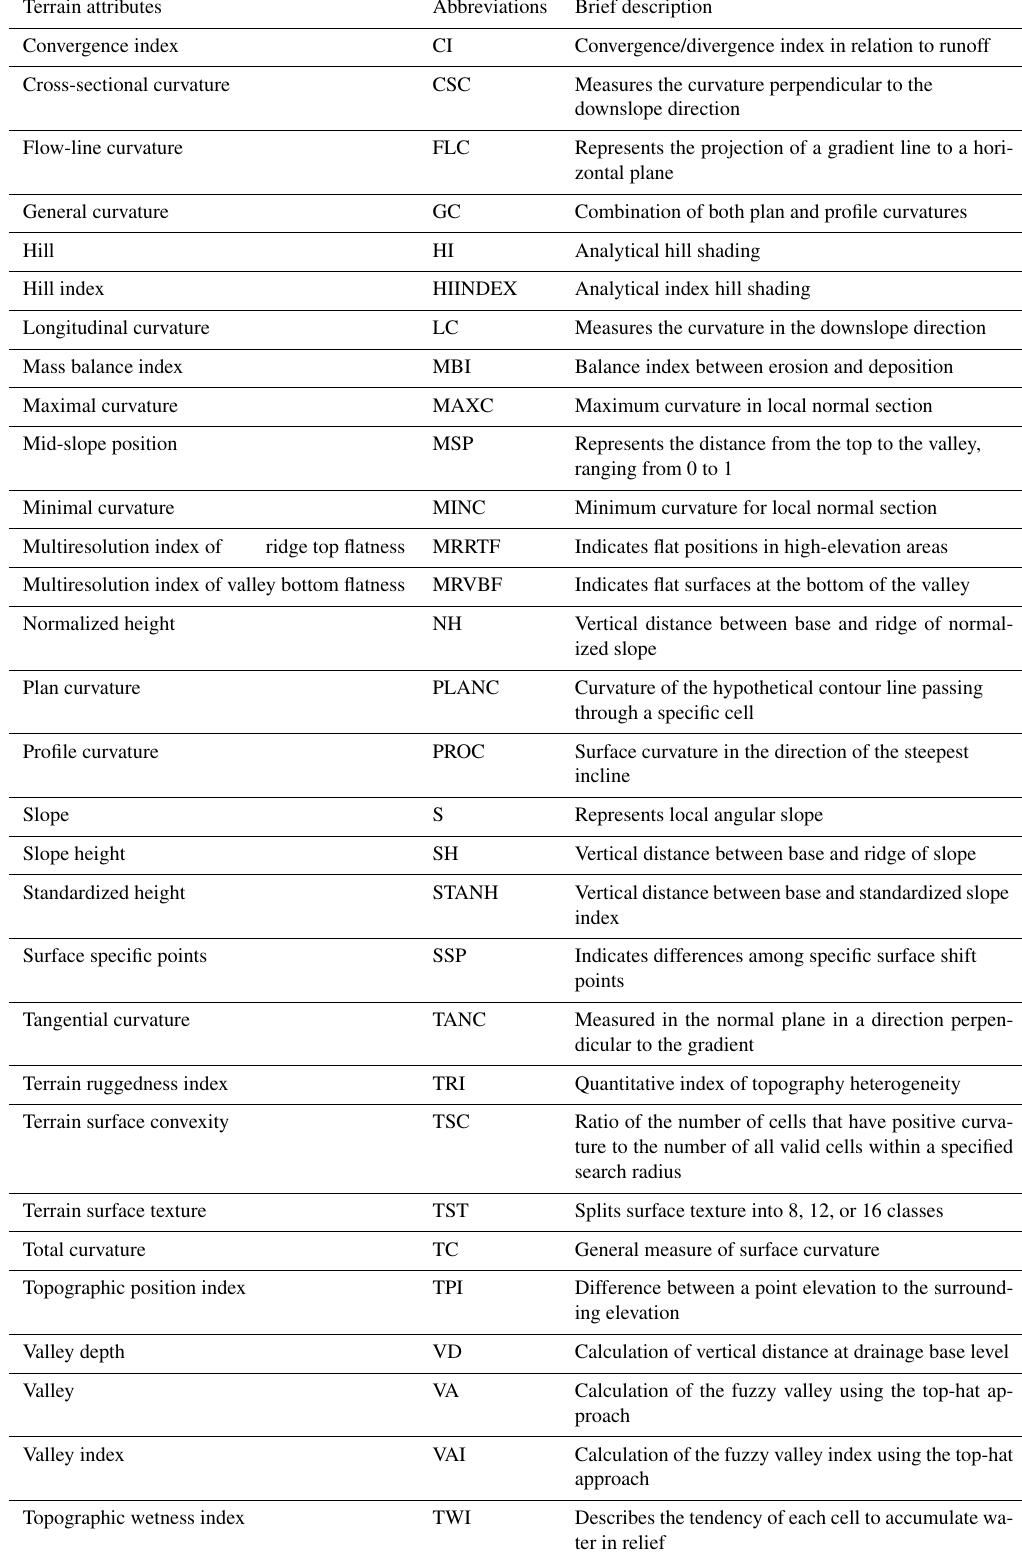
Table 1. Terrain variables generated from the digital elevation